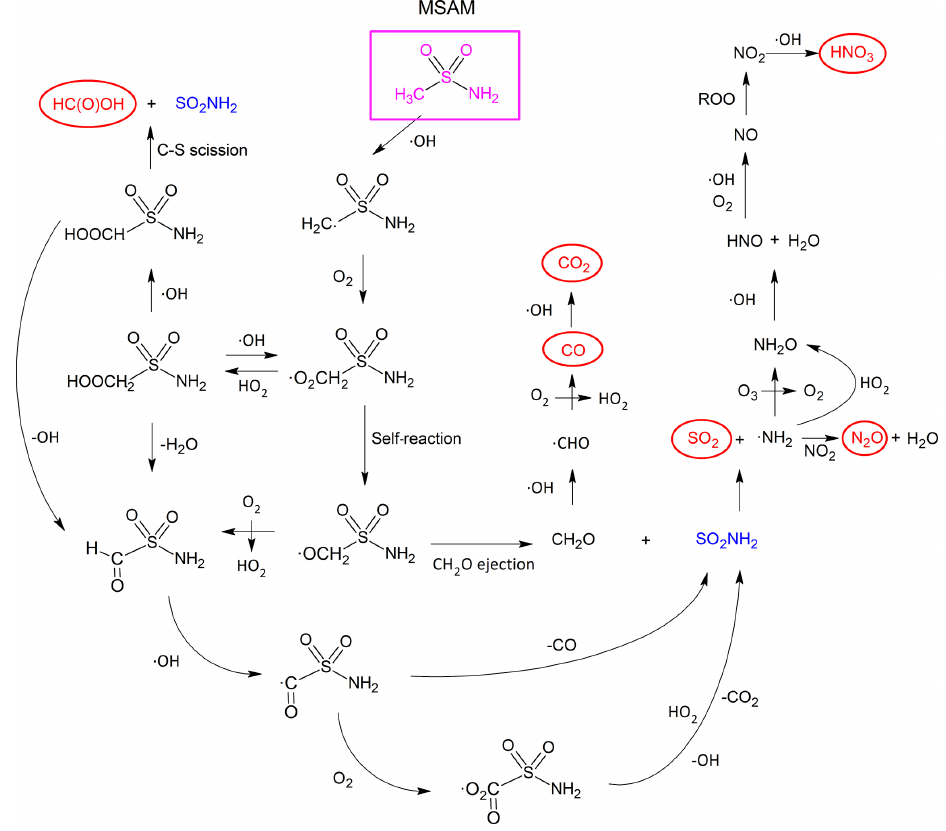
Figure 7. Mechanism for the formation of carbon-containing (HC ( O ) OH, CO, CO 2 ), nitrogen-containing (HNO 3 and N 2 O), and sulfur- containing (SO 2 ) end products (in red circles) observed in the OH-initiated photo-oxidation of MSAM.